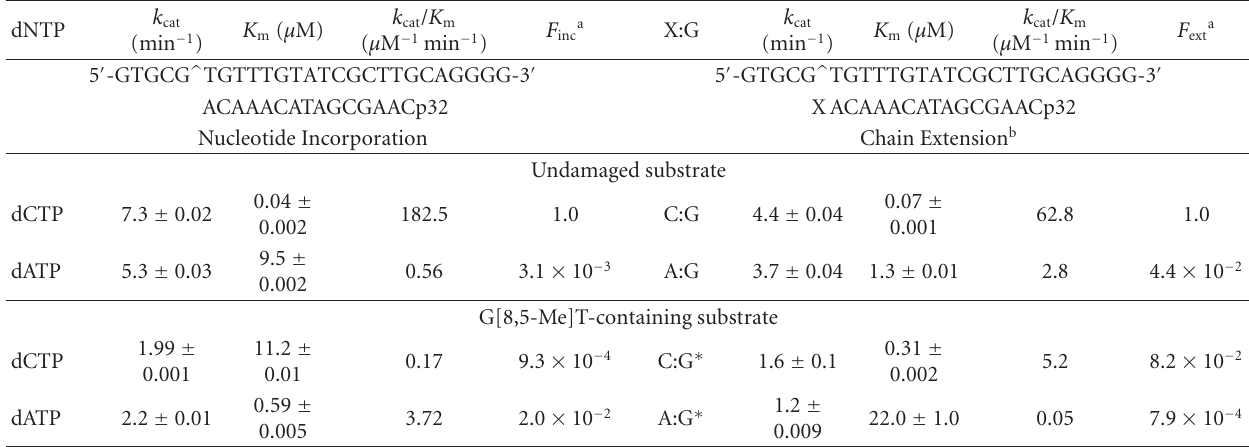
Table 2: Kinetic parameters for dCTP and dATP incorporation and chain extension by yeast DNA polymerase η (6.4nM) on an undamaged and G[8,5-Me]T cross-link containing